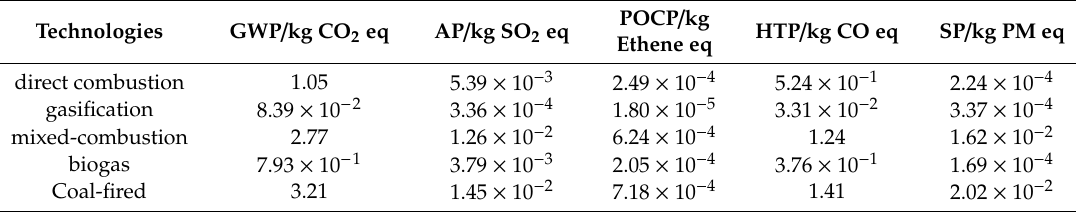
Table 3. Characterization results of di ff erent power generation processes.